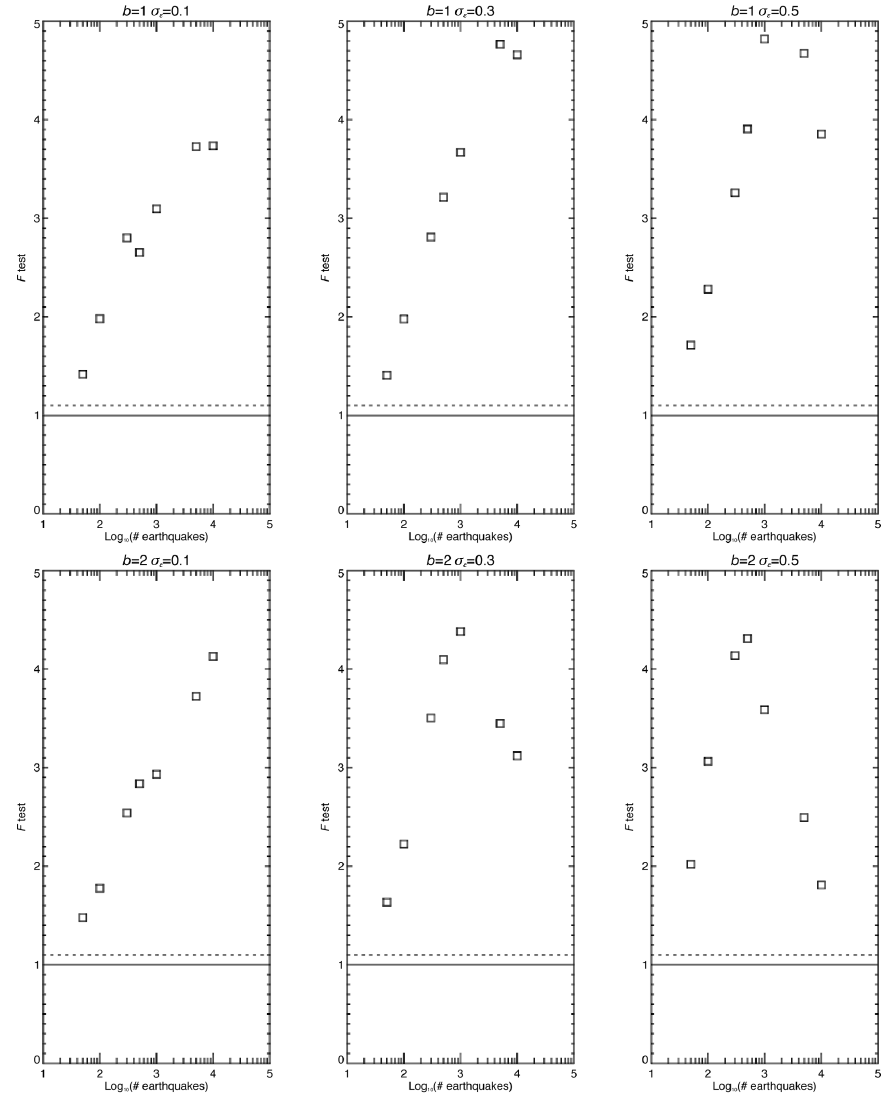
Fig. 7. F test values (see eq. (2.2)) for the case of fig. 6 (see text). The dotted line represents the critical value to reject the null hypothesis at a significance level of